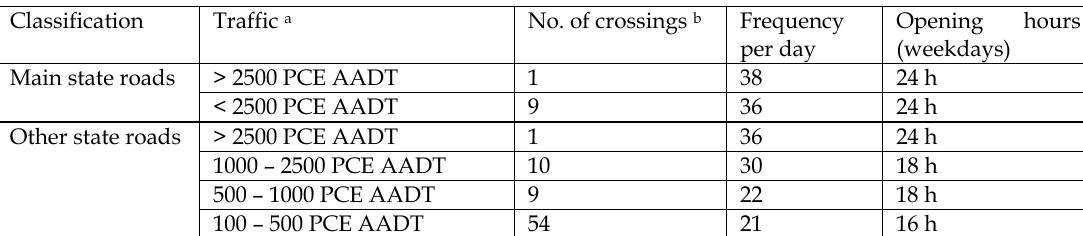
Table 1. Extract from the national ferry standard for the Norwegian ferries Classification Traffic a No. of crossings